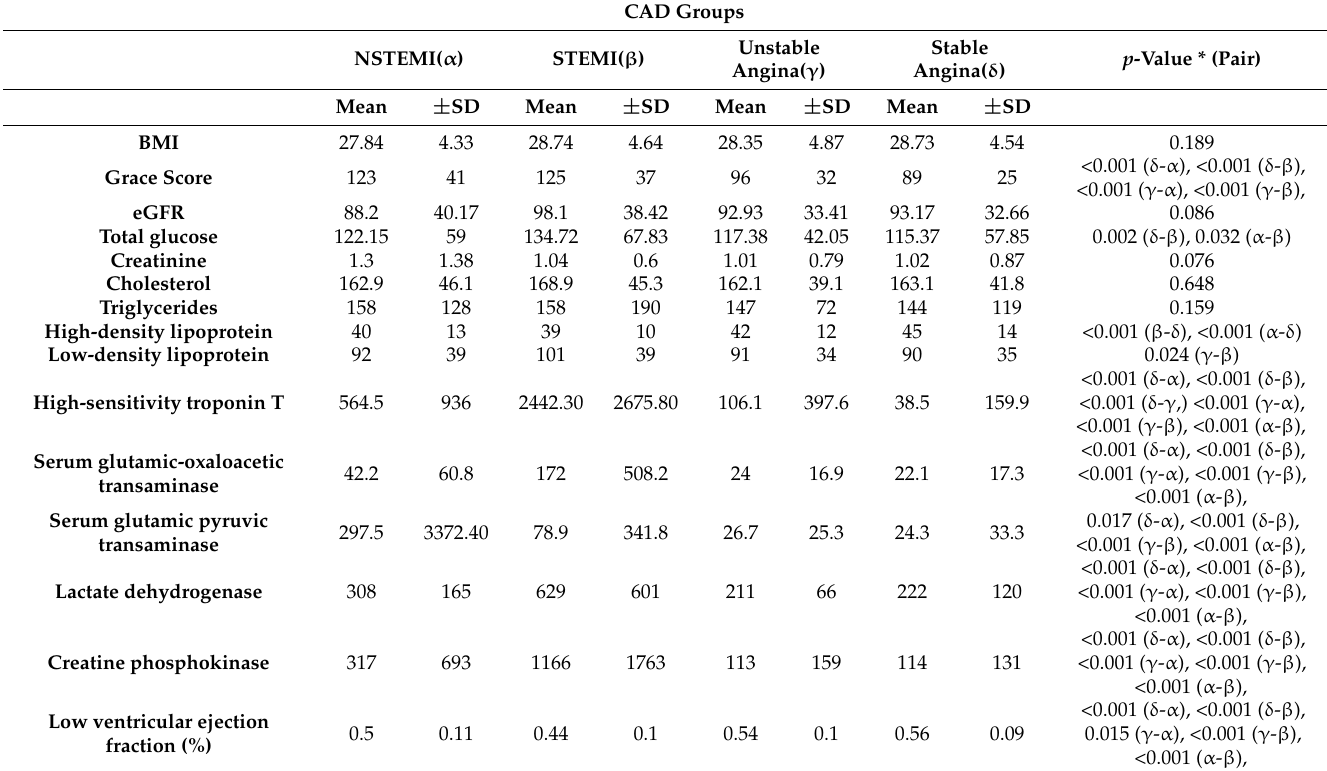
Table 4. Descriptive analyses of continuous variables per CAD subgroup. CAD